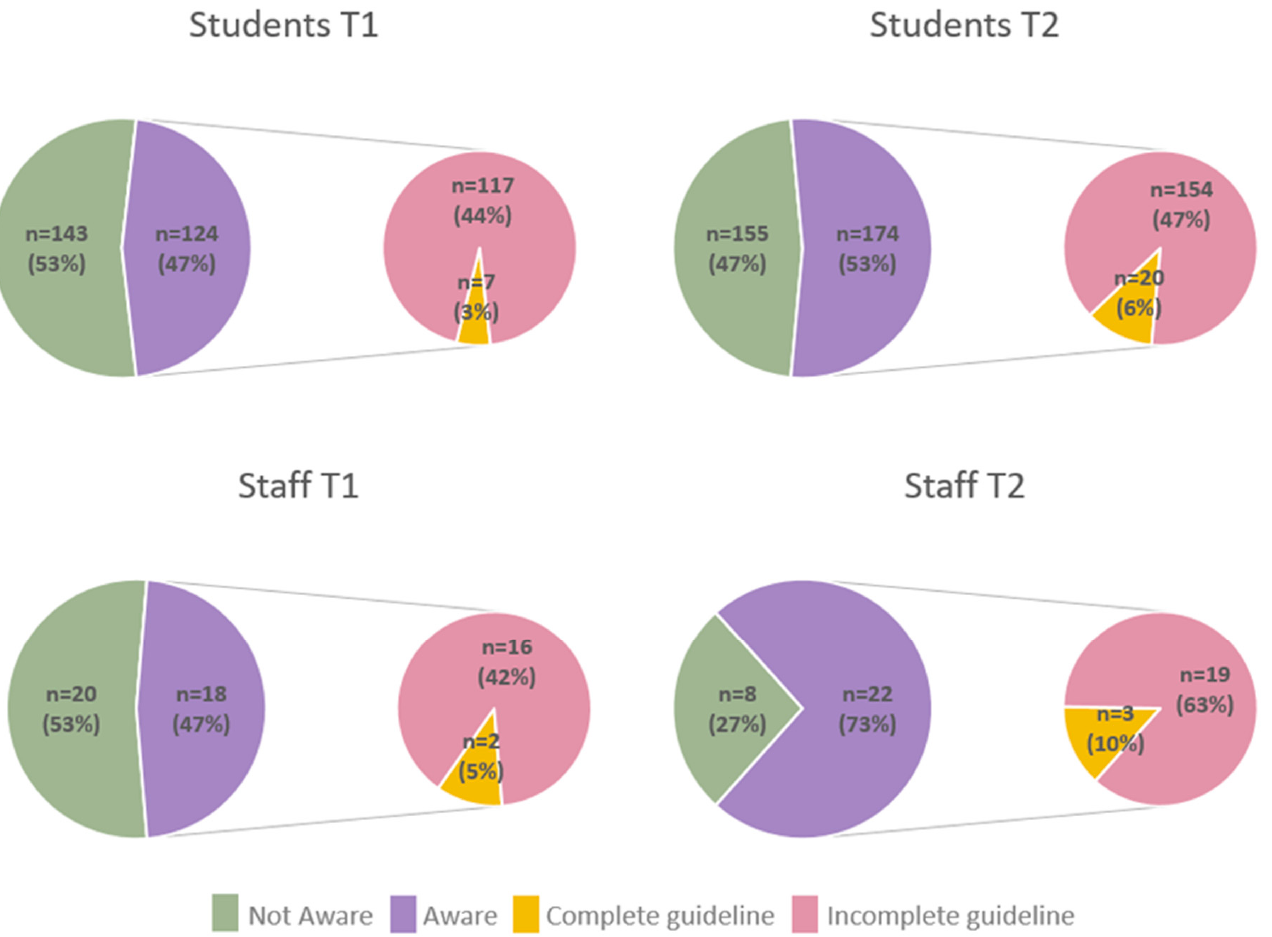
Figure 1. Awareness and knowledge of the Australian Physical Activity and Sedentary Behaviour guidelines among health students and staff pre- (T1) and post-intervention (T2).